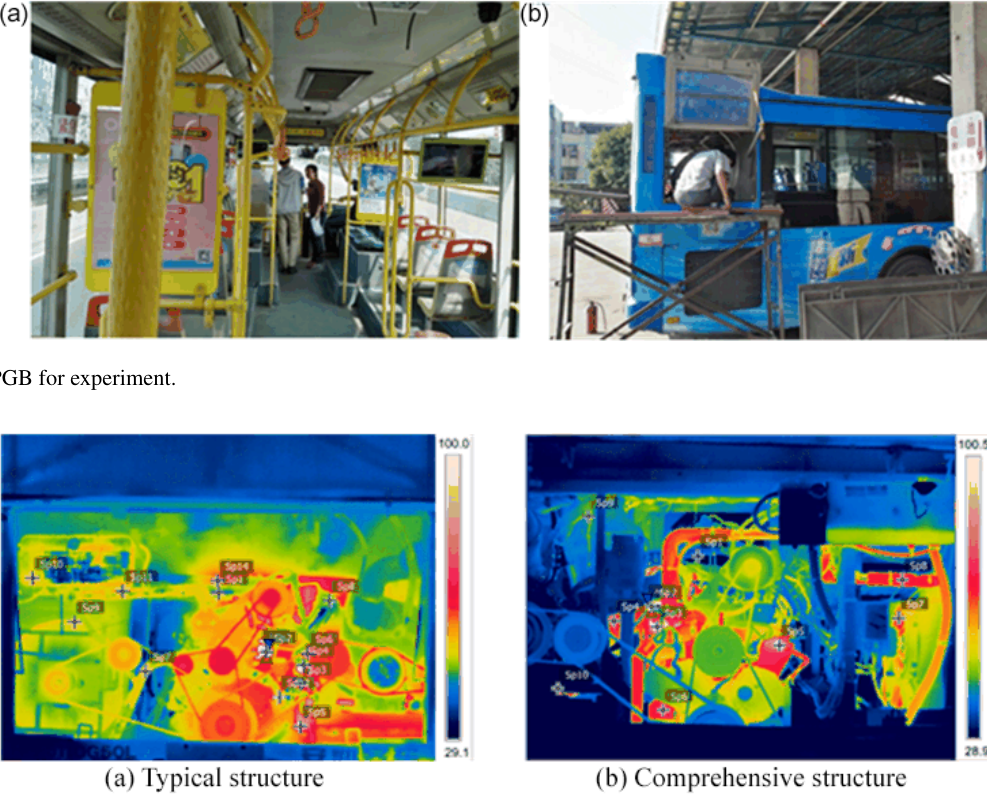
Figure 16. Infrared imaging temperature field map of high-temperature components in typical and comprehensive structure from the + Y direction under the 600rmin − 1 steady-state